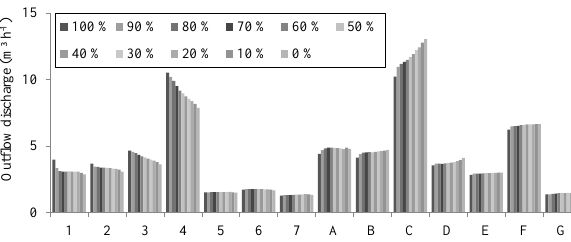
Figure 13. Observed outflow discharges in each street for when the inflow through the west face ( ϕ west ) is varied between 100 and 0%.